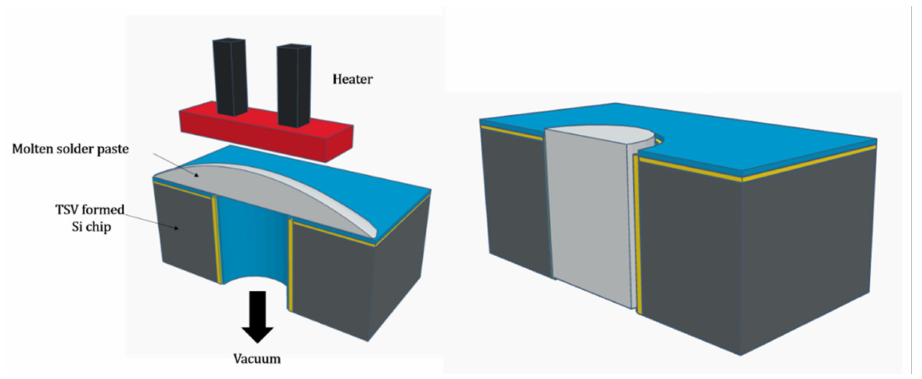
Figure 13. Process of TSV filling with molten